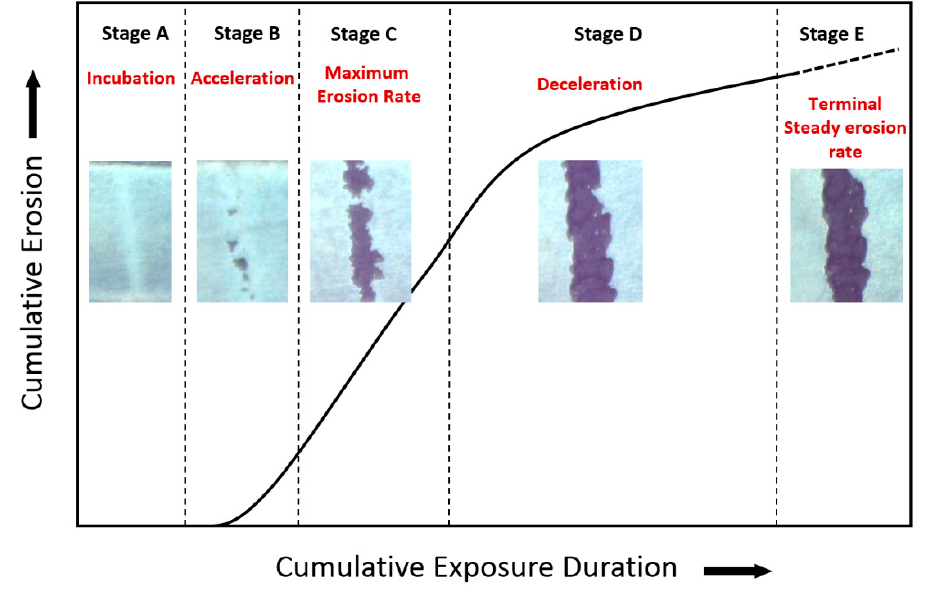
Figure 11. Typical stages in water droplet erosion damage curves. The insets are Ti64 tested at 300 m/s impact velocity with droplets of 460 µm size.